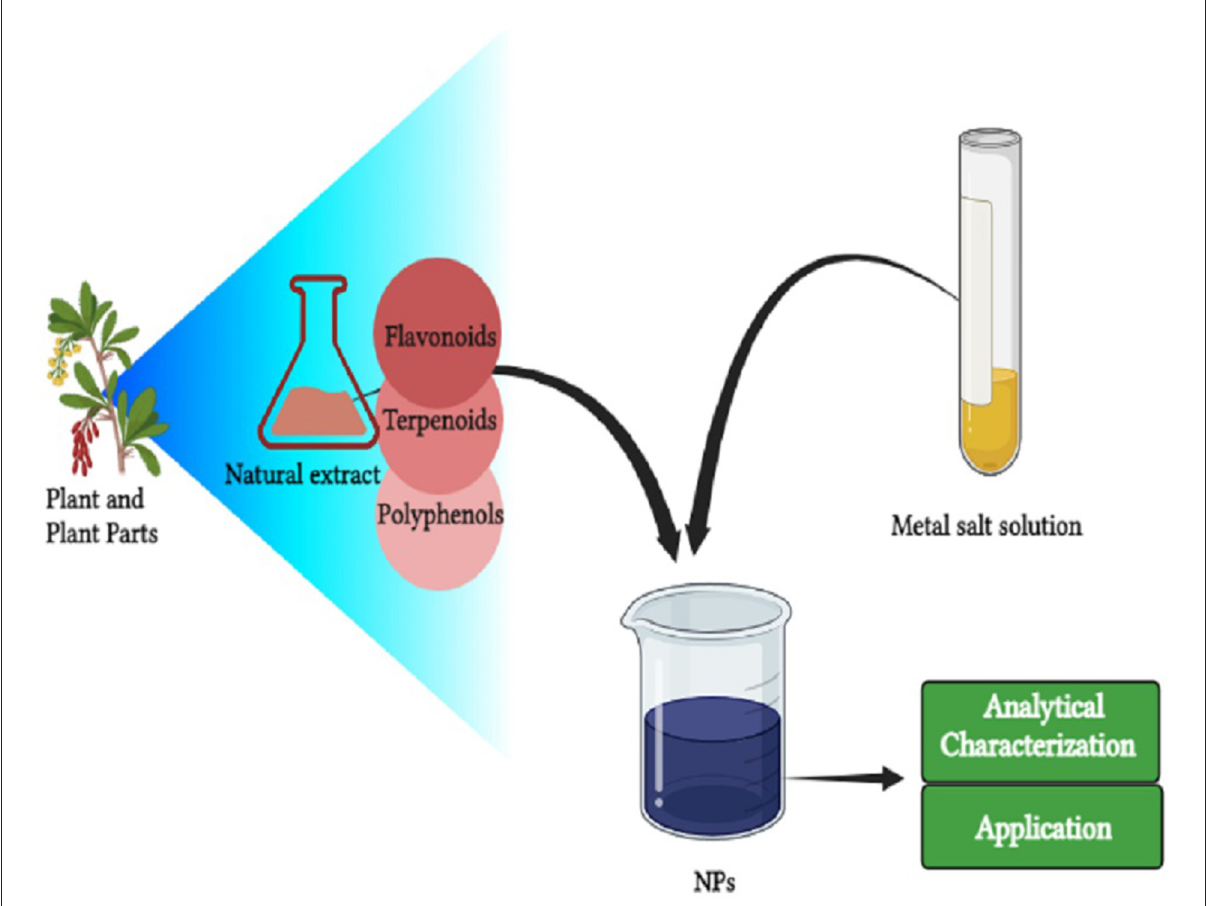
FIGURE1 Green synthesis of NPs using plant